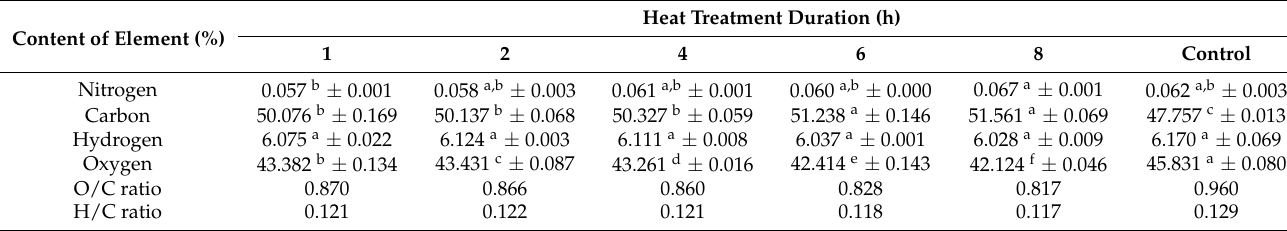
Table 5. The ultimate analysis of control and heat-treated